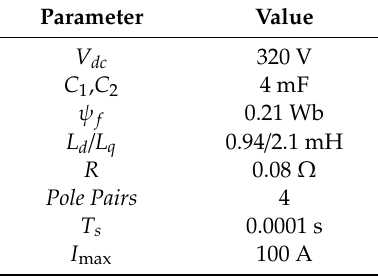
Figure 9. Experimental setup.